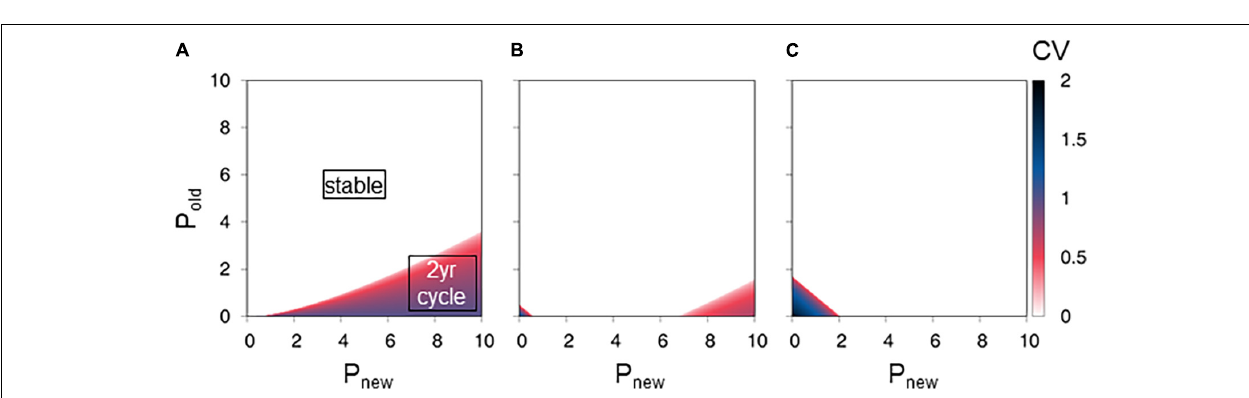
FIGURE 4 | Effect of net photosynthesis rate in new leaves of zero-year-old culms on new shoot production. The figures show the final state coefficient of variation (CV) values from a series of P new_N 0 values of (A) 0.0, (B) 5.0, and (C) 10.0. The color gradation bar represents the CV. Parameter settings of the lower-right red region generate the 2-year cycles of production. Parameter settings of the central white region generate stable production. Parameter settings of the lower-left blue region generate more than 2-year cycles or chaotic